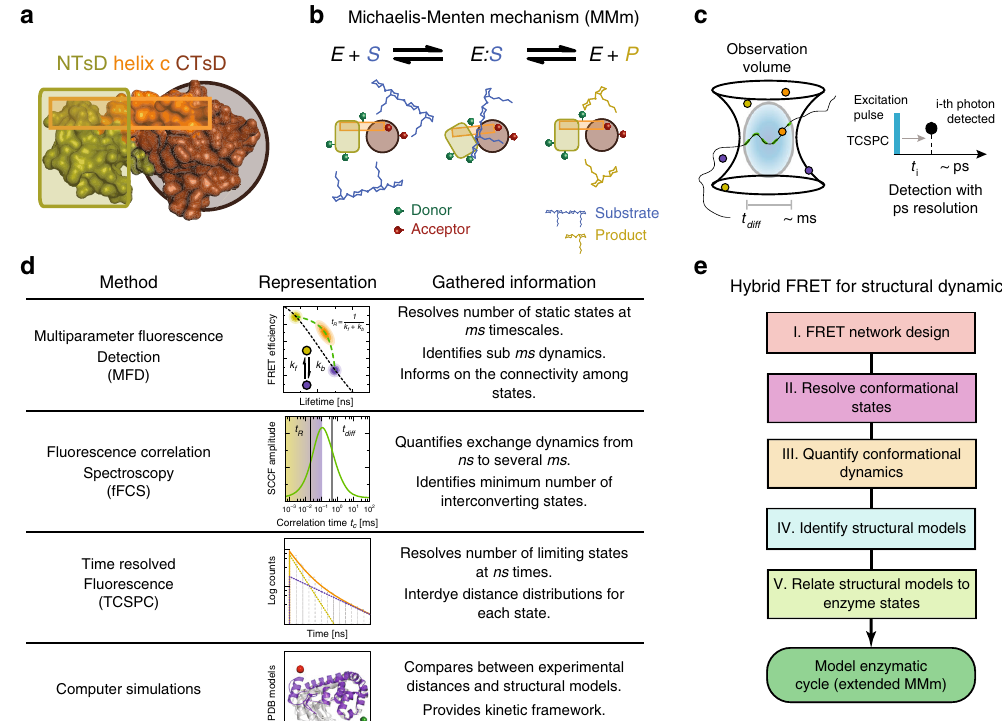
Fig. 1 Schematic of the high precision FRET and fl uctuation analysis toolkit. a Subdomain architecture of Phage T4 Lysozyme (T4L). b Upon cleavage of its substrate peptidoglycan (blue), the N-terminal lobe (green) and the C-terminal lobe (brown) of T4L exhibit a change of closure, which can be observed via the induced change in the FRET indicators 14,15 . c In MFD-experiments of freely diffusing single molecules, the emitted fl uorescent photons ( “ bursts ” ) are detected with ps resolution (with respect to the exciting laser pulse) during the diffusion (on the ms time scale) of the molecule through the observation volume (diffusion time, t diff ). d The labeled T4L molecules are studied with different experimental methods. In single-molecule multiparameter fl uorescence detection (MFD) experiments, the fl uorescence bursts — averaged over ms — are analyzed e.g. with respect to their fl uorescence lifetime 〈 τ 〉 fi ciency E and displayed in multidimensional frequency histograms (2D MFD-histogram). Molecules that adopt a stable conformation F or FRET-ef (A) during burst duration are located along the static FRET-line (black) (Supplementary Methods). Assuming that the two limiting states (yellow and blue) exchange on timescales faster than ms with exchange rate constants k f and k b , we fi nd only a single population (orange) shifted towards a longer fl uorescence lifetime that is located on the dynamic FRET-line (green) connecting these two limiting states. Thus, FRET-lines serve as a visual guide to interpret 2D MFD-histograms, with deviations from the static FRET-line being indicative for the dynamic averaging and dynamics at the sub-ms and ms timescales. Filtered fl uorescence correlation spectroscopy (fFCS) computes the species-speci fi c cross-correlation function (sCCF (green),